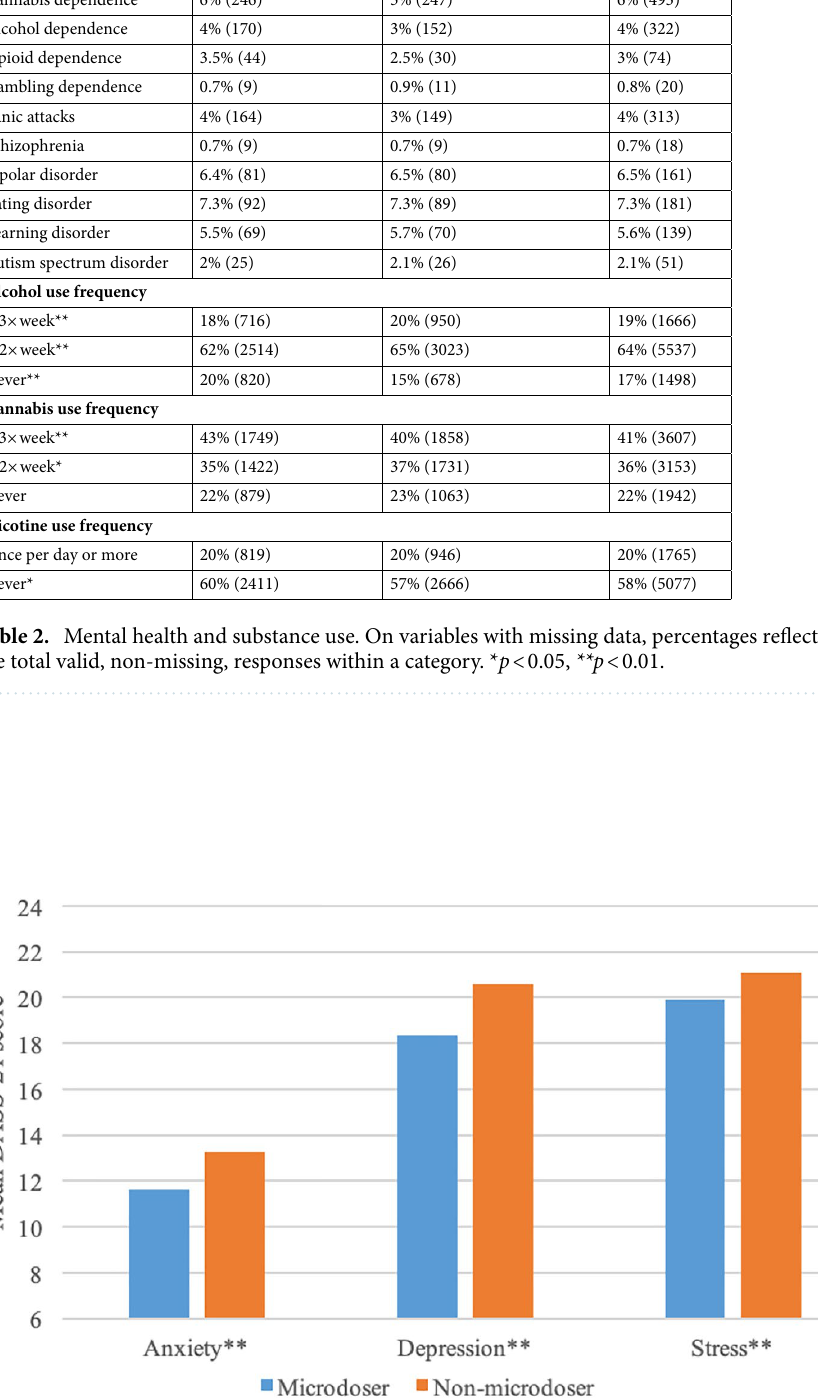
Figure 2. Microdosing and mental health. Note: ** p < 0.01, n = 1651, anxiety, depression and stress drawn from DASS-21 subscales (range: